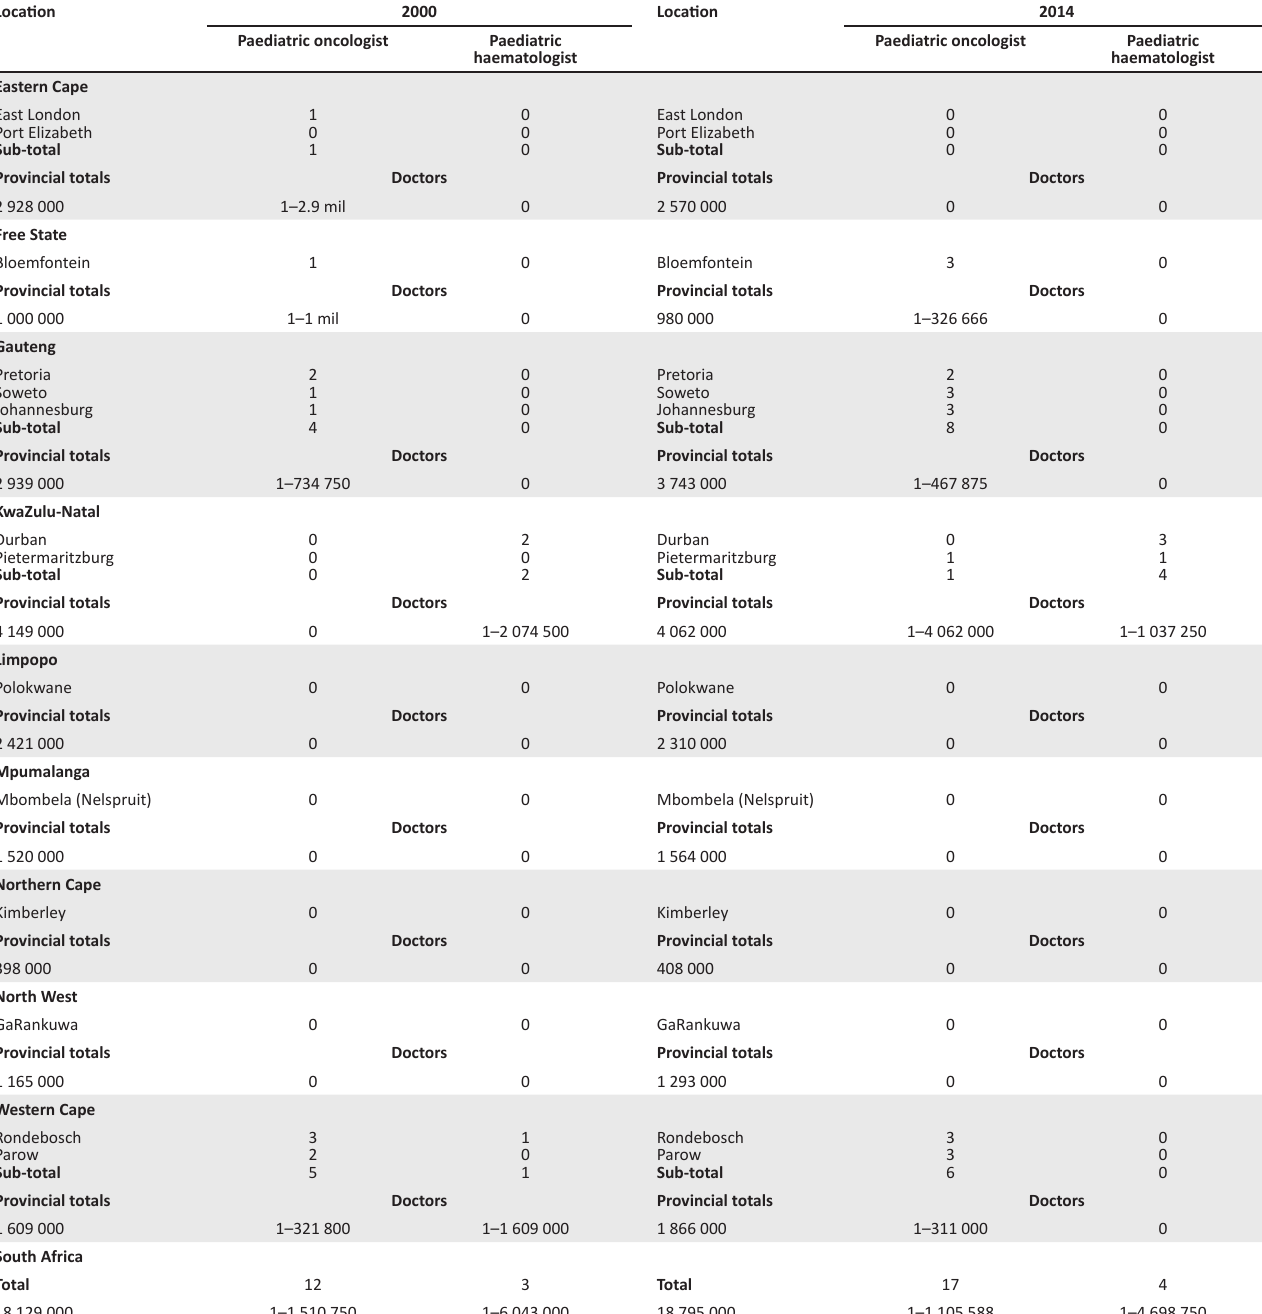
TABLE 8: The number of paediatric oncologists/haematologists in each province between 2000 and 2014.